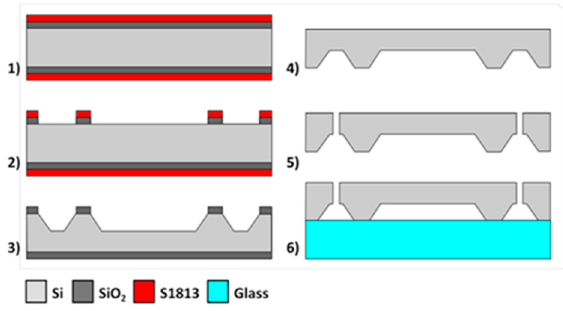
Figure 7. Flow chart of the microfabrication process for the microfluidic interface test.